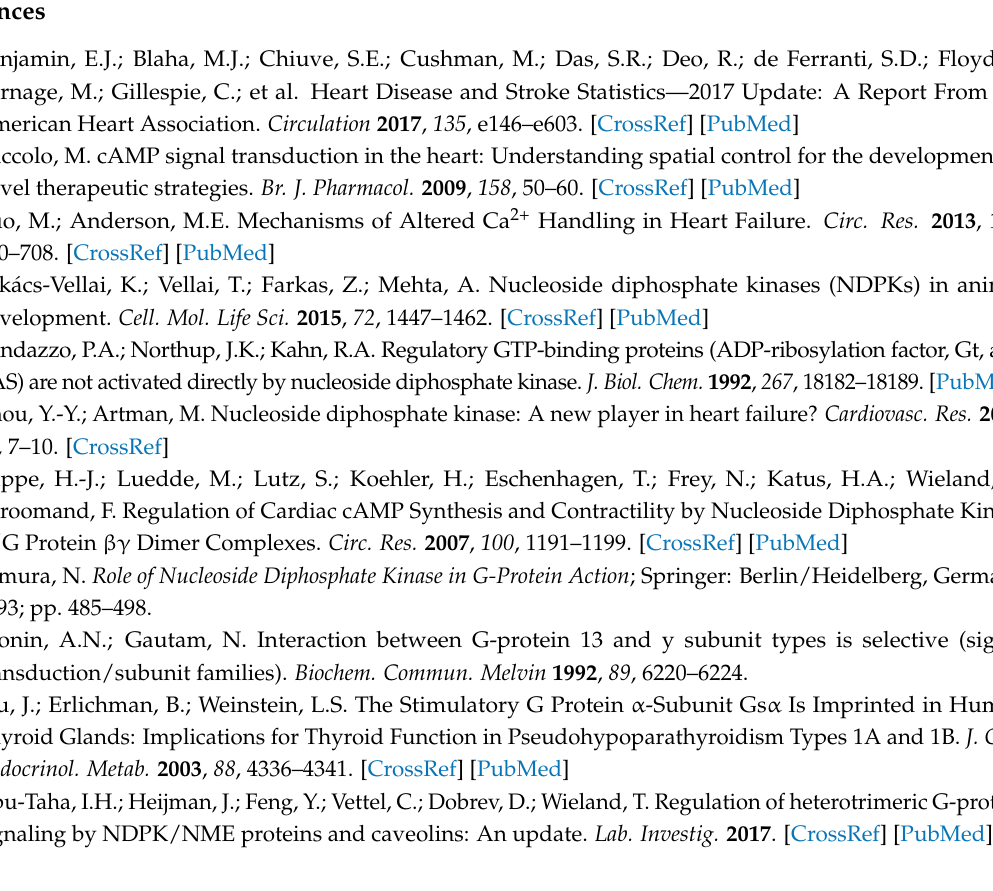
Figure S1: Secondary structure timeline analysis computed by VMD’s timeline plug-in, Figure S2: Root Mean Square Fluctuation (RMSF) of the His118 residue from the four monomers, P1, P2, P3 and P4 in the absence (A) and presence (B) of graphene oxide; Figure S3: Secondary structure analysis of the NDPK enzyme in the absence of graphene oxide showing the His118 residue from the four monomers P1, P2, P3 and P4 undergoing conformational